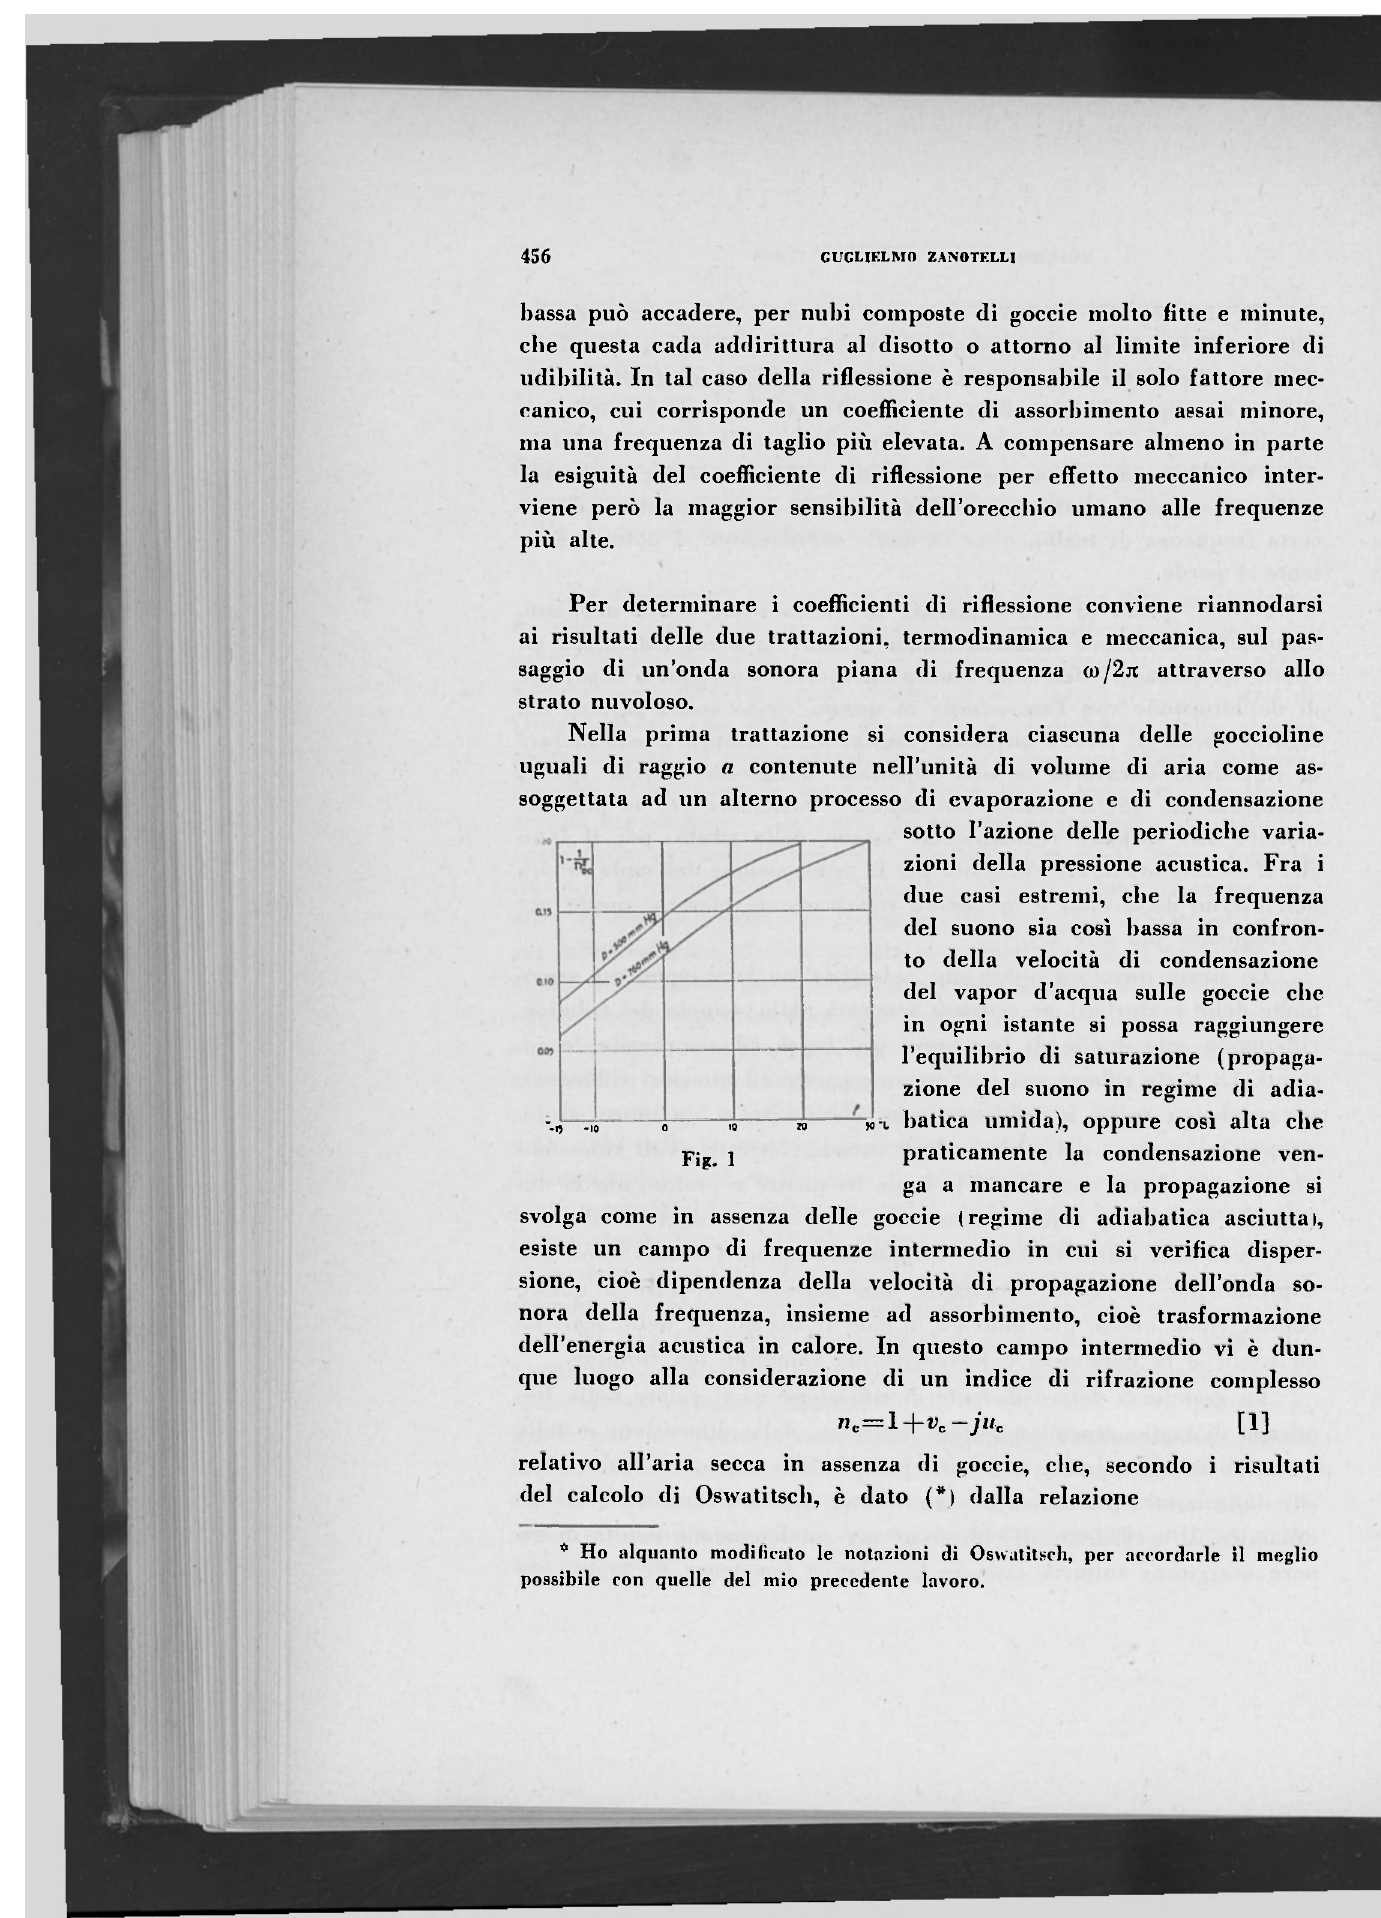
Fig j praticamente la condensazione